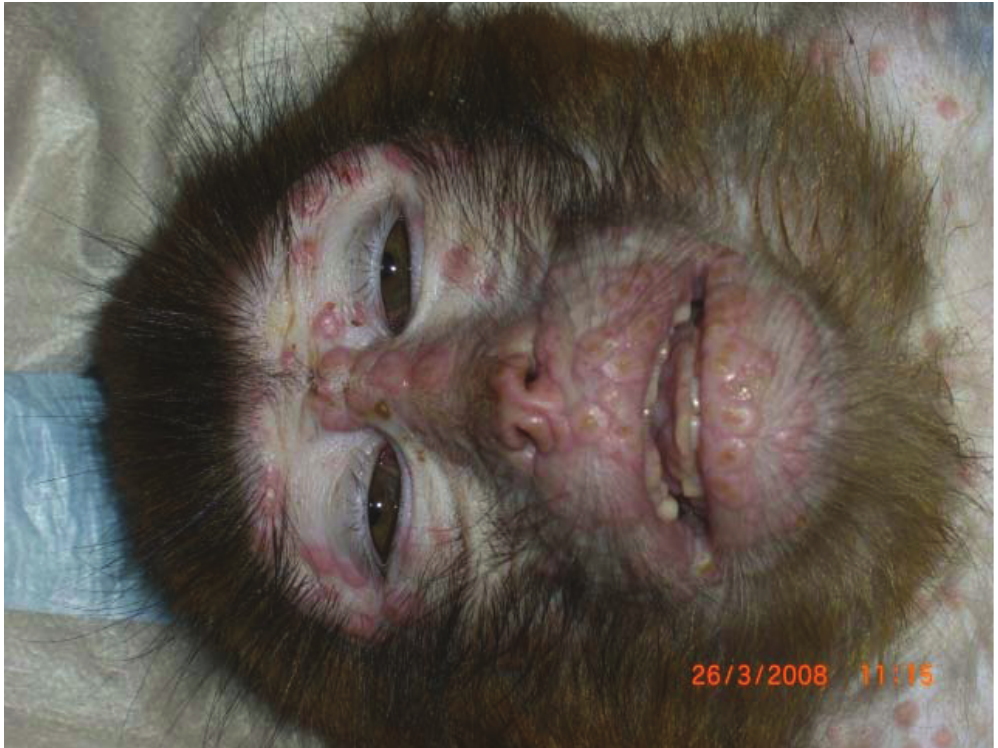
Figure 1. Monkeypox virus infected Macaca mulatta ( M. mulatta ) with multifocal severe papular